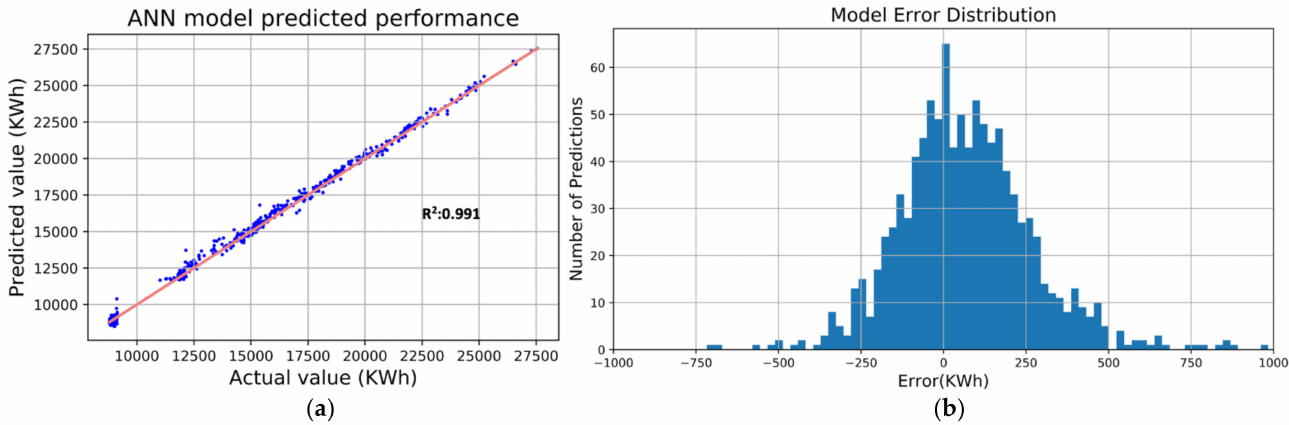
Figure 5. The prediction performance of annual NG consumption: ( a ) Model Prediction Performance; ( b ) Model Error Distribution.